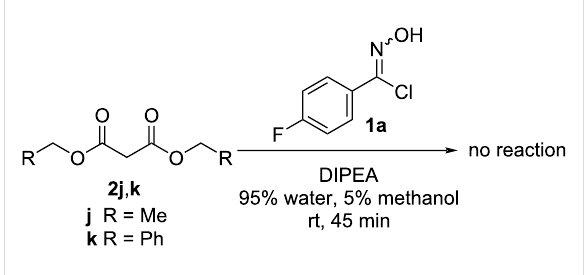
Figure 5: Reactions between 4-fluorophenyl hydroximoyl chloride ( 1a ) and diethyl malonate ( 2j ) or dibenzyl malonate ( 2k ) did not proceed.